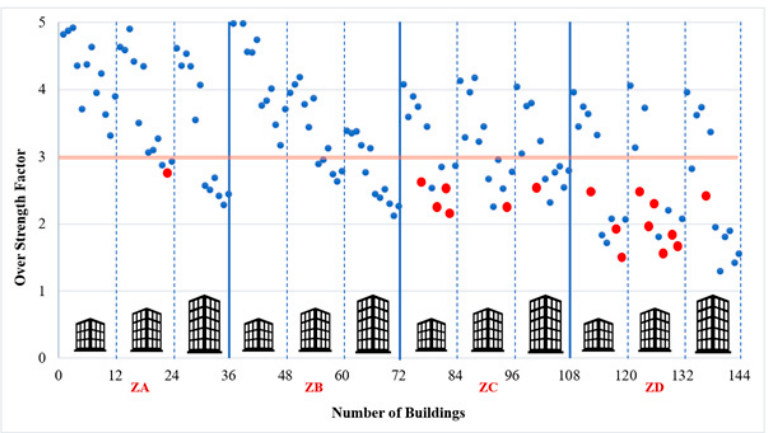
Figure 20. Distribution of the over-strength factor for all models according to the number of buildings and soil types (for nonlinear analysis).